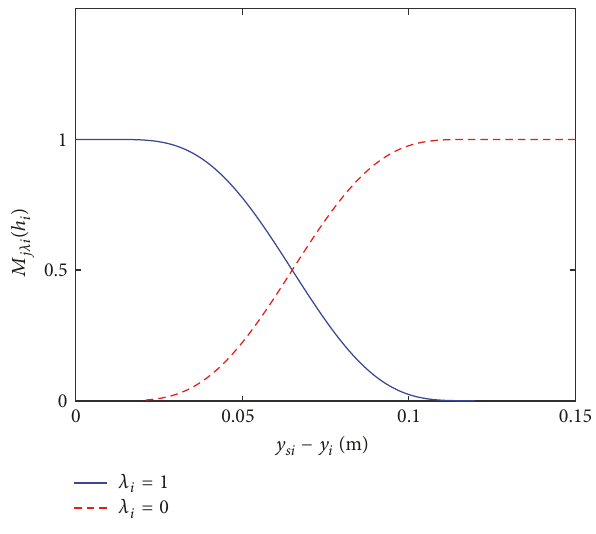
Figure 2: Fuzzy membership weight.